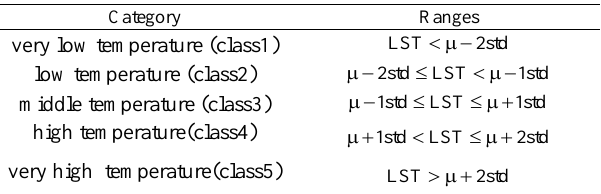
Table 2. Usage of mean-standard deviation method to